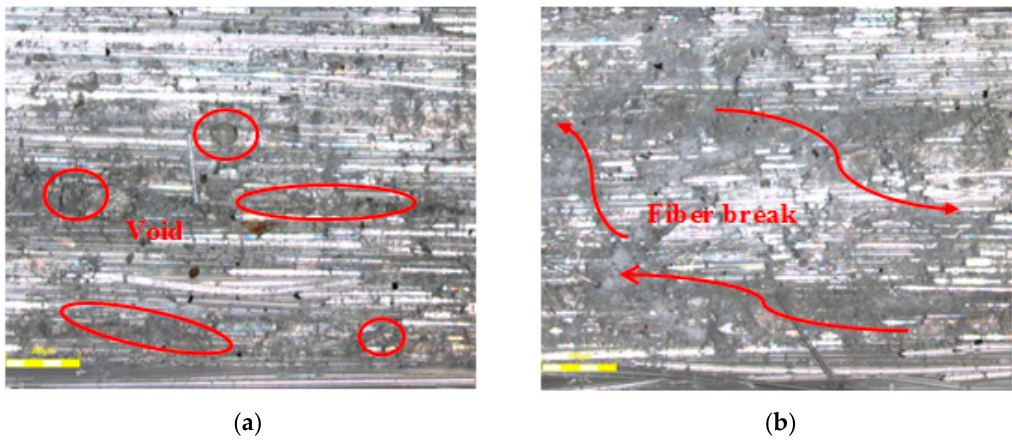
Figure 9. Microscopic images of group A: ( a ) N = 5034; ( b ) N = 8160.